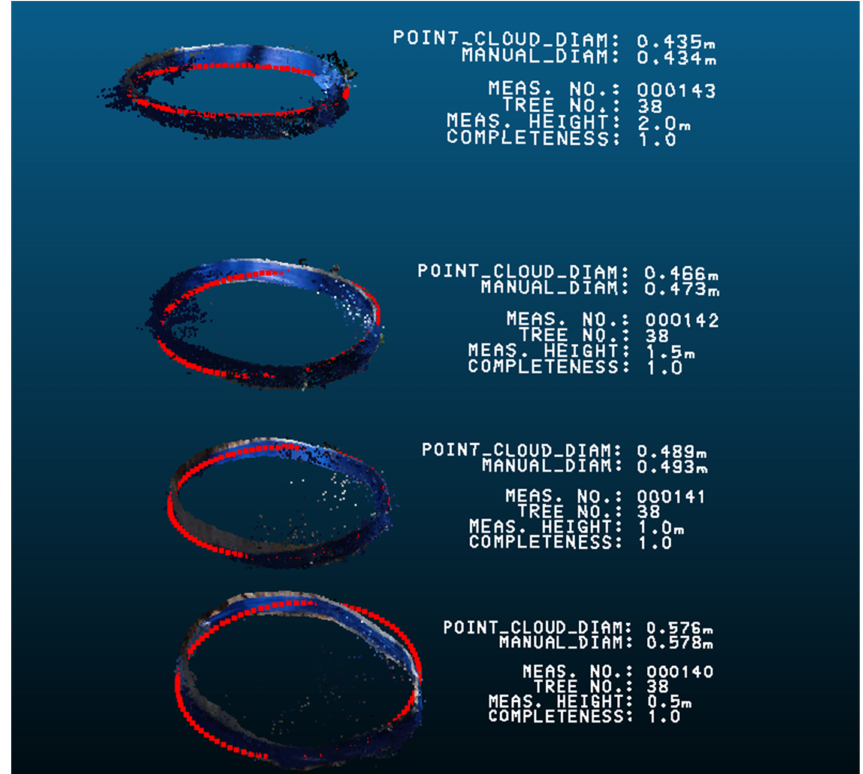
Figure 8. Visualization of the circles (shown in red) which were fitted using random sample consensus (RANSAC) to the manually sliced blue marking tape stem circles. The measurements shown above are: RANSAC fitted circle diameter (POINT_CLOUD_DIAM), manually measured diameter (MANUAL_DIAM), and Circumferential Completeness Index